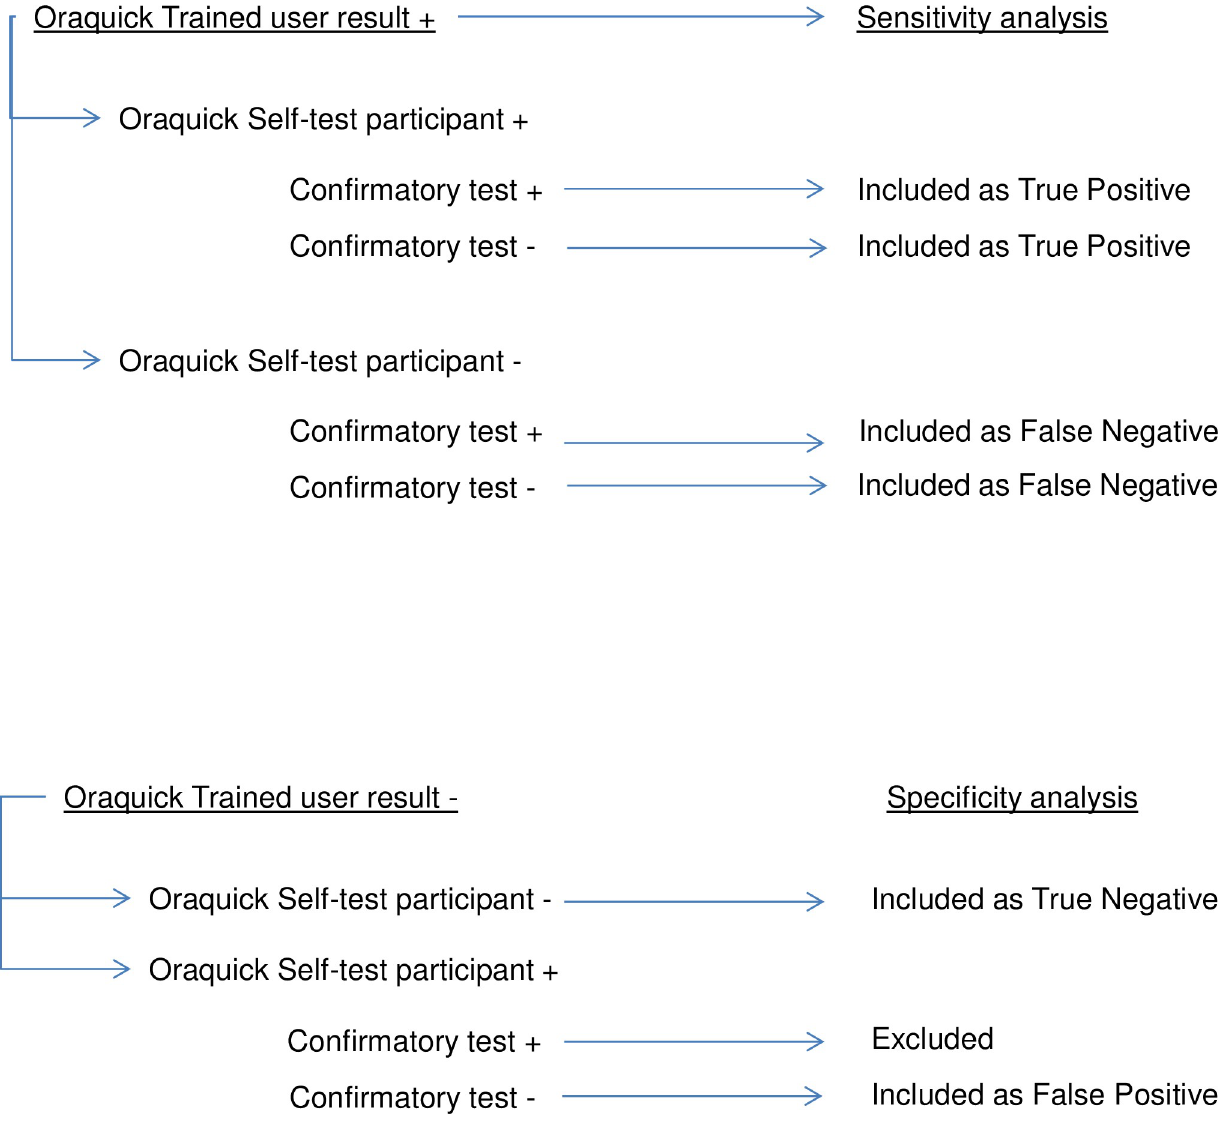
Fig 1. Flowchart sensitivity and specificity